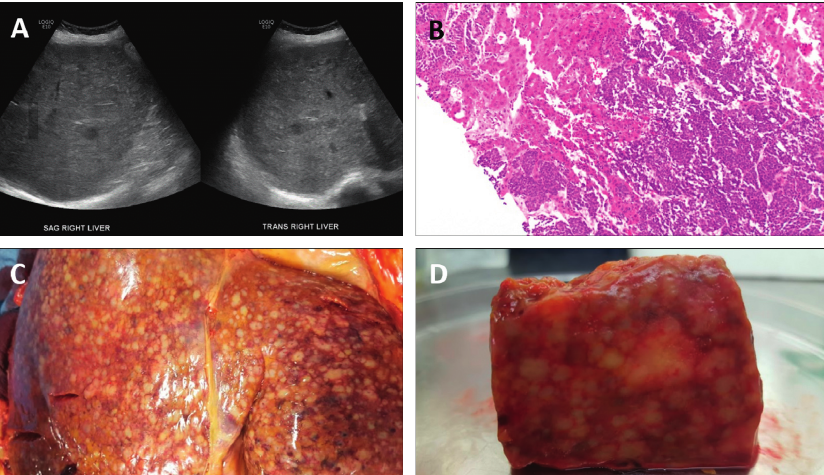
Figure 6: (a) Right upper quadrant ultrasound, hospital day 4, was notable for diffusely heterogeneous hepatic parenchyma with scattered hypoechoic lesions, suspicious for malignancy. No intrahepatic biliary ductal dilatation was observed. (b) Core liver biopsy revealed metastatic disease occupying roughly 60% of the total parenchyma. Background hepatic parenchyma was without signs of marked in- flammation. (c) Gross inspection of the liver revealed replacement of the parenchyma by firm tan/yellow confluent nodules and punctate hemorrhagic areas. (d) Cross section of hepatic tissue recapitulated overwhelming tumor